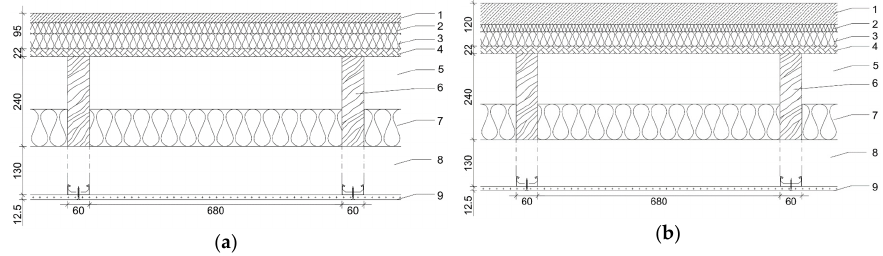
Figure 2. Cross-sections of model 1c ( a ) and 1d ( b ) of the wooden frame floor. 1–self-leveling screed, 2–mineral wool ρ = 150 kg/m 3 , 3–mineral wool ρ = 107 kg/m 3 , 4–OSB board, 5–air gap, 6–wooden joints, 7–mineral wool ρ = 12 kg/m 3 , 8–air gap, 9–plaster board.